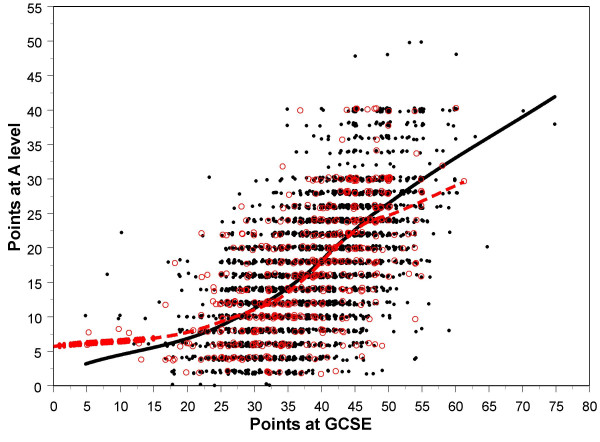
The relationship between points achieved at GCSE and points achieved at A-level, separately for W students (solid black points and solid black line) and NW students (open red points and dashed red line). All data points have been jittered slightly so that they do not overlap. The fitted lines are loess regression lines.